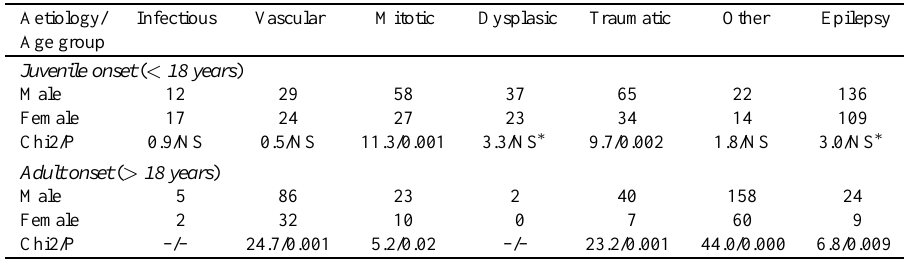
Table 2 Frequencies of aetiologies of the brain lesions, and of epilepsy, as a function of age-group and sex Aetiology/ Infectious Vascular Mitotic Dysplasic Traumatic Other Epilepsy Age